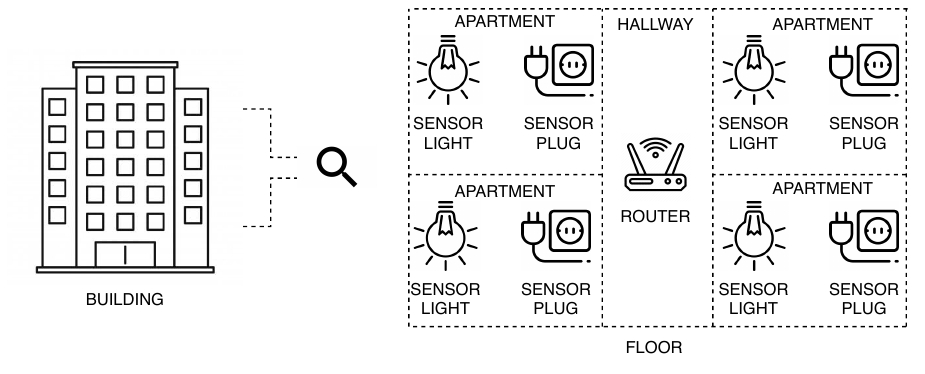
Figure 5. Building’s